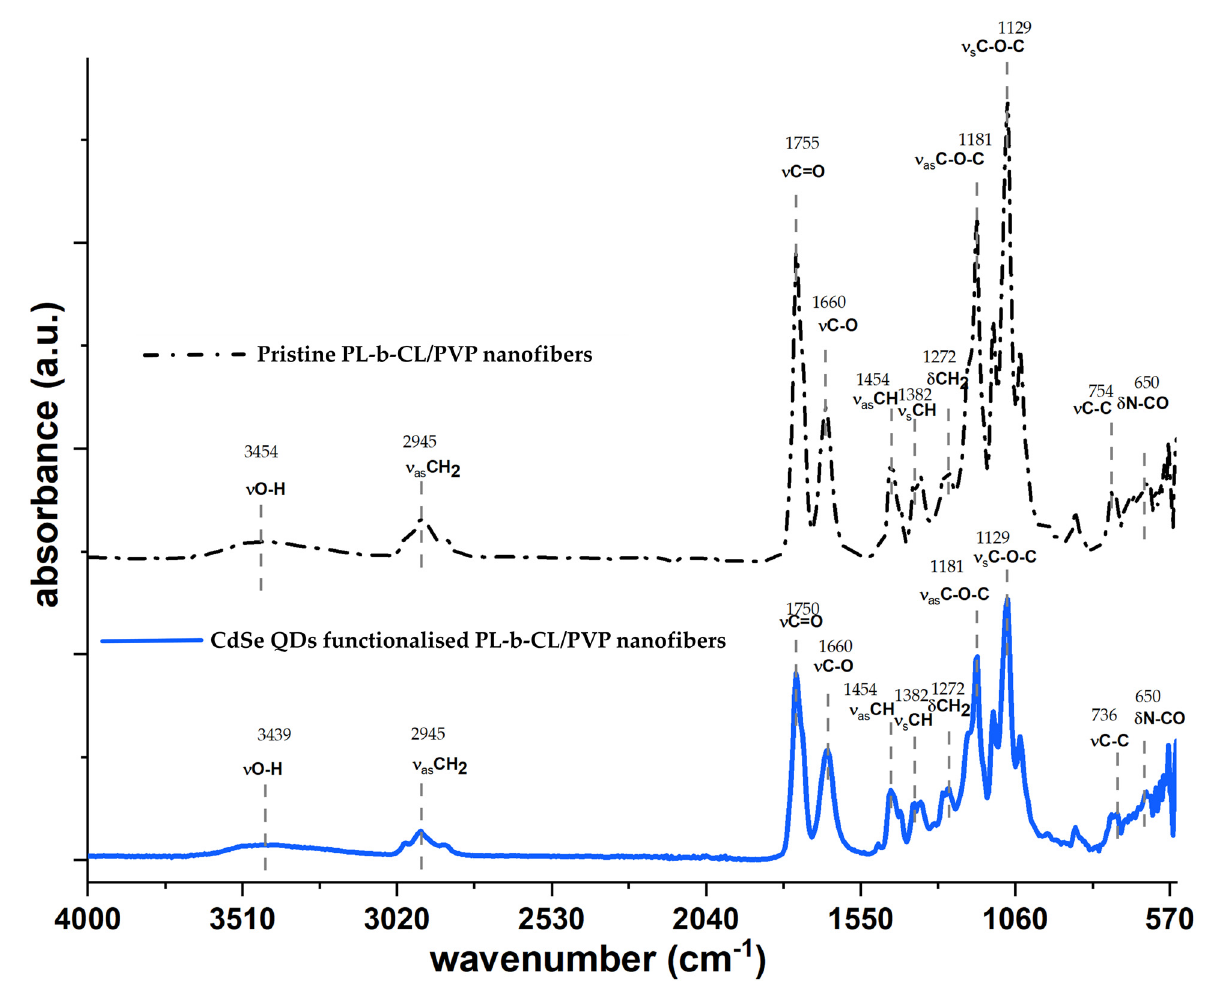
Figure 5. FTIR (ATR) spectroscopy absorbance showing comparison between pristine and CdSe QDs-functionalized PL-b-CL/PVP nanofibers. Addition of PVP-stabilized CdSe QDs show a slight change in absorbance under infrared spectroscopy.